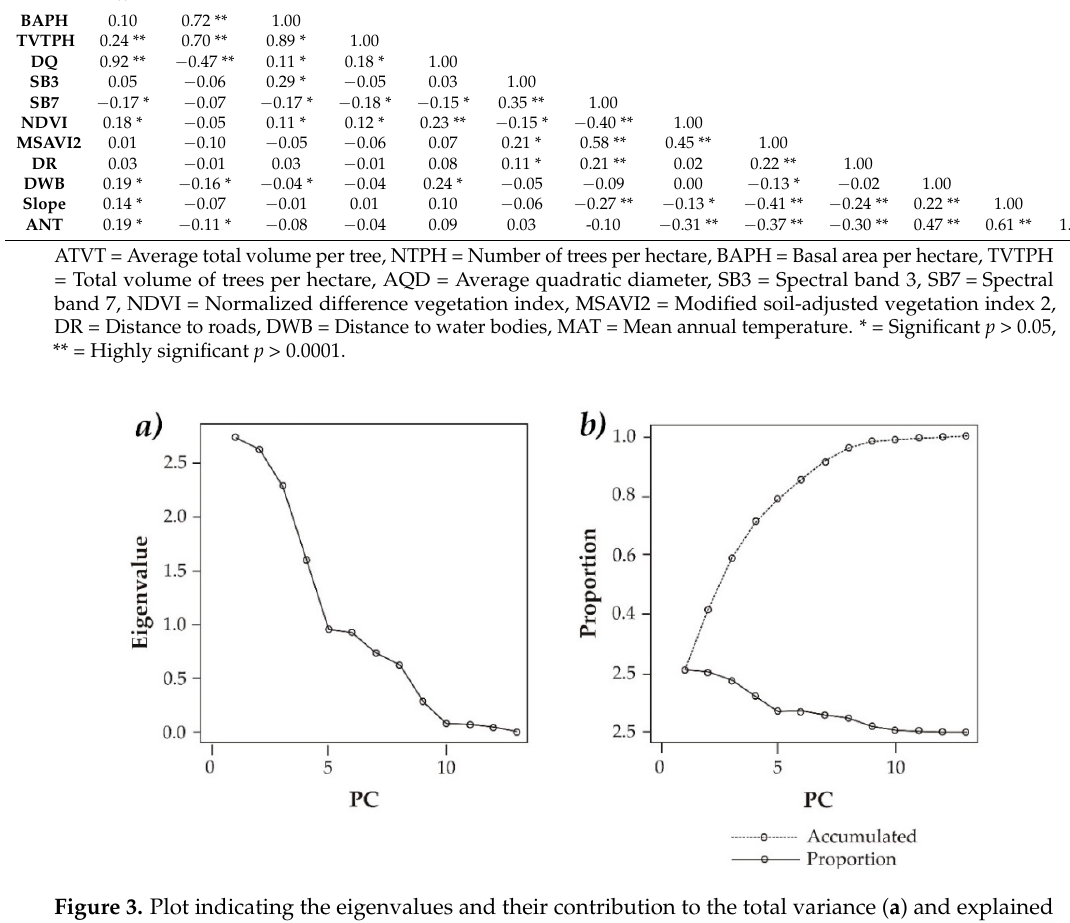
Figure 3. Plot indicating the eigenvalues and their contribution to the total variance ( a ) and explained variance ( b